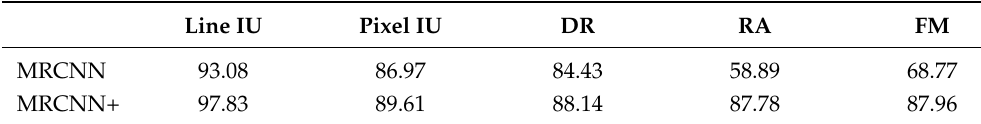
Table 3. Results of the proposed method on the VML-AHTE dataset. DR denotes detection rate, RA denotes recognition accuracy, and FM denotes F-measure.